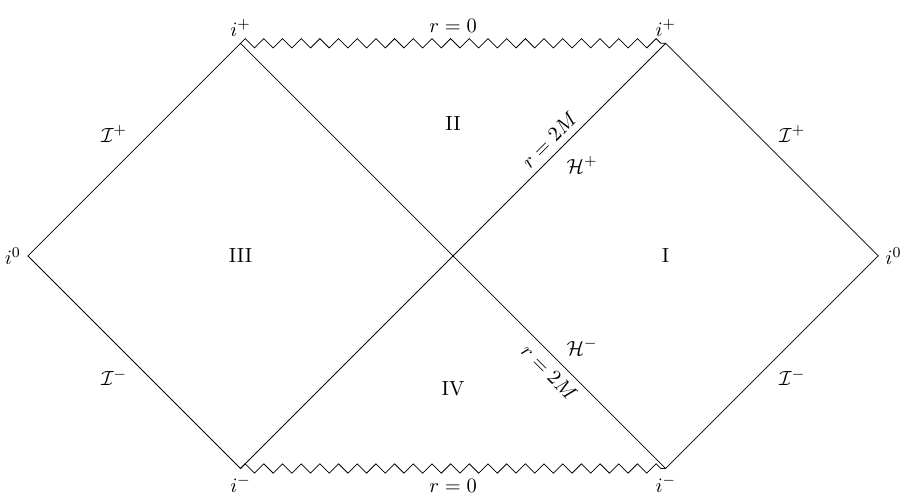
Figure 1 . Conformal diagram for Schwarzschild